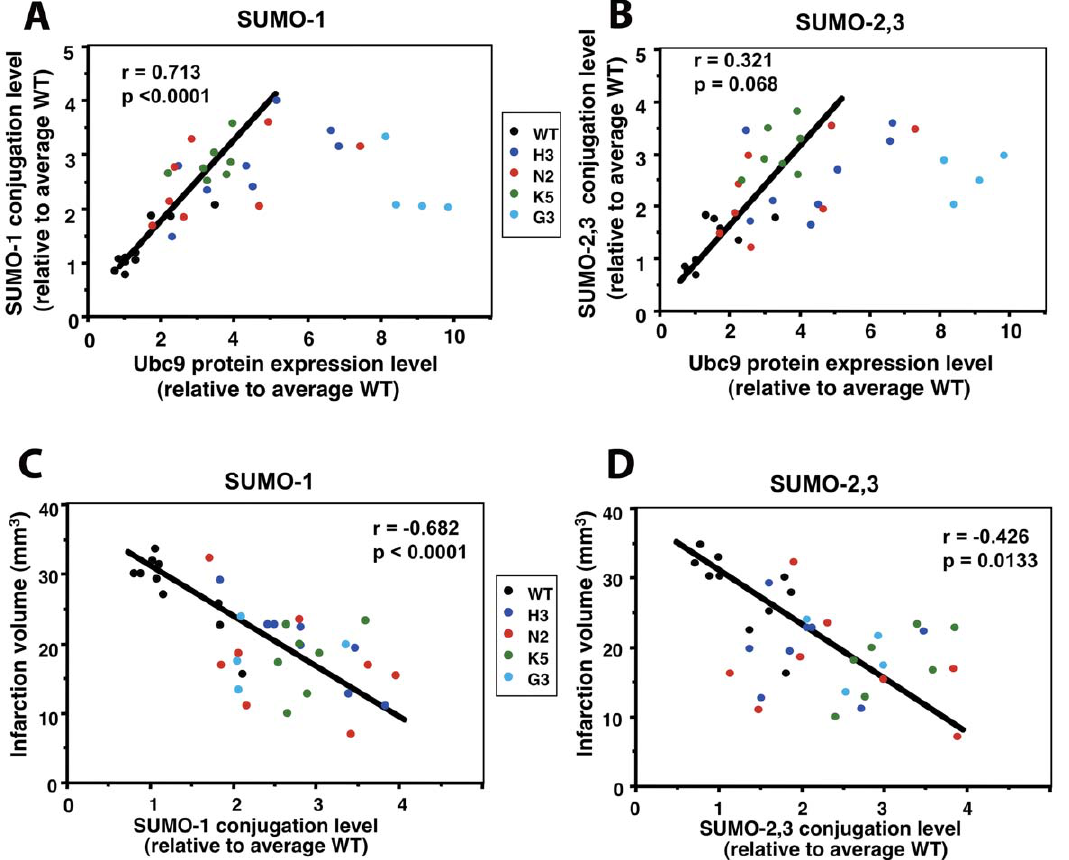
Figure 4. Correlation of SUMO-1 HMW-conjugates or SUMO-2,3 HMW- conjugates with either Ubc9 level or infarction volume. (A) The brain SUMO-1 HMW-conjugates level (y-axis) after 24 h pMCAO was plotted against the Ubc9 level (x-axis) in the same sample. Animals whose Ubc9 levels were under 5-fold the wild type show a significant correlation. (n=42; r: Pearson correlation coefficient=0.713, p , 0.0001). (B) The brain SUMO-2,3 HMW-conjugates level (y-axis) was plotted against the Ubc9 level (x-axis) in the same sample. Animals whose Ubc9 levels were under 5-fold the wild type show only a trend toward correlation. (n=42; r=0.321, p=0.068). (C) The brain infarction volumes (y-axis) after 24 h pMCAO were plotted against their SUMO-1 HMW-conjugates levels (x-axis). (n=42; r= 2 0.682, p , 0.0001). (D) The brain infarction volumes (y-axis) after 24 h pMCAO were plotted against their SUMO-2,3 HMW-conjugate levels. (n=42; r= 2 0.426, p=0.0133).